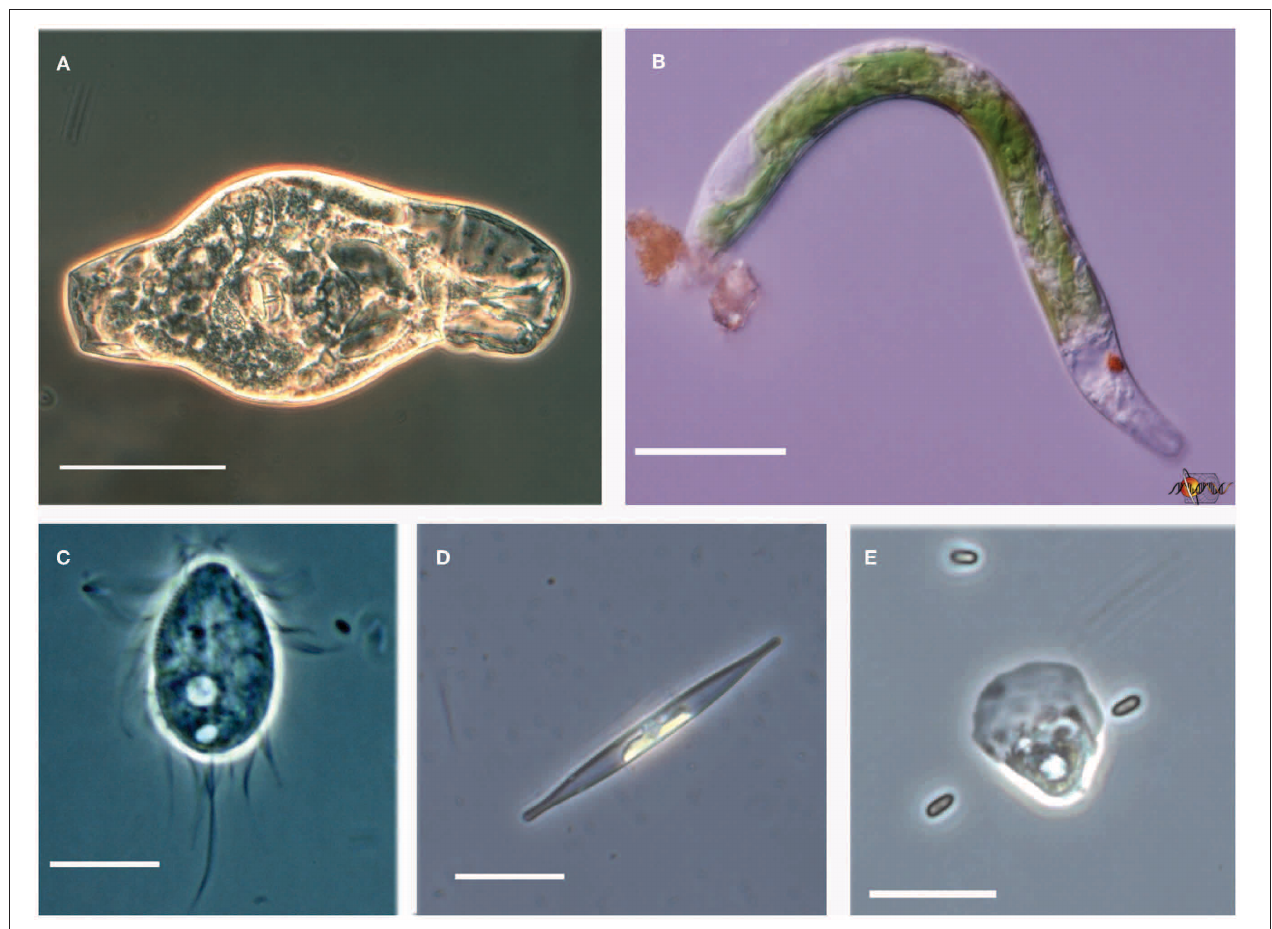
FIGURE 6 | Examples of pH extremophiles. (A) Rotifer from the Rio Tinto (scale bar = 50 µ m). (B) Euglena mutabilis from Davis Mine, MA (scale bar = 20 µ m). (C) Cyclidium sp. ciliate from Mallard Lake,